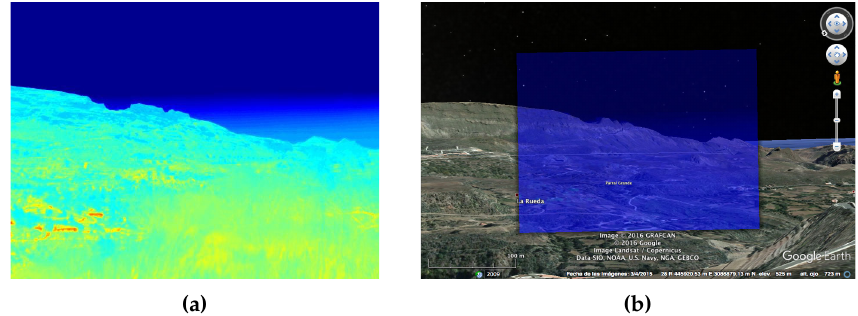
Figure 3. Thermographic image equivalent to the synthetic image after attitude compensation. ( a ) Thermographic image. ( b ) Thermographic image superimposed on Google